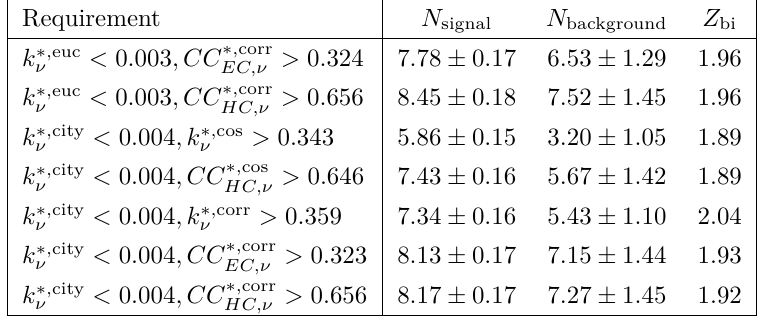
Table 2. Examples of binomial significances for search regions that provide exclusion sensitivity without reducing yields below 3 events. The errors only include the statistical